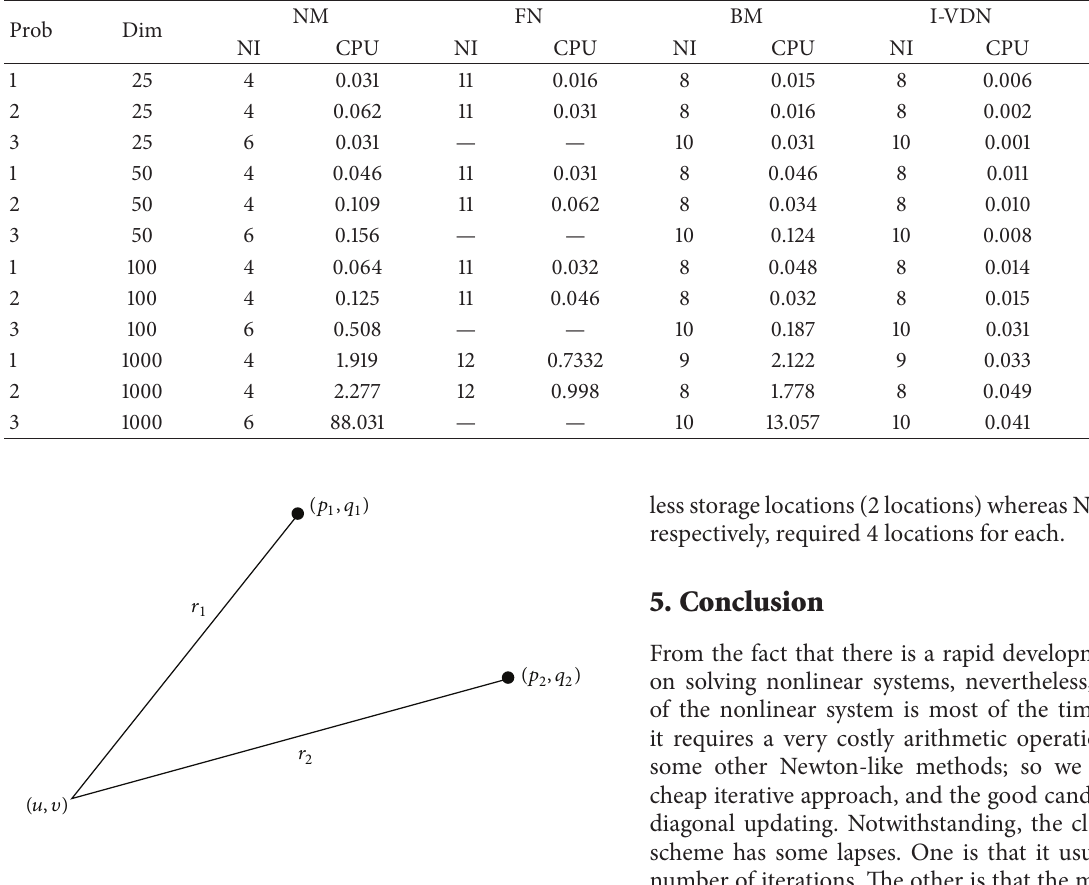
Table 1: Numerical comparison of NM, FN, BM, I-VDN, and EMFM